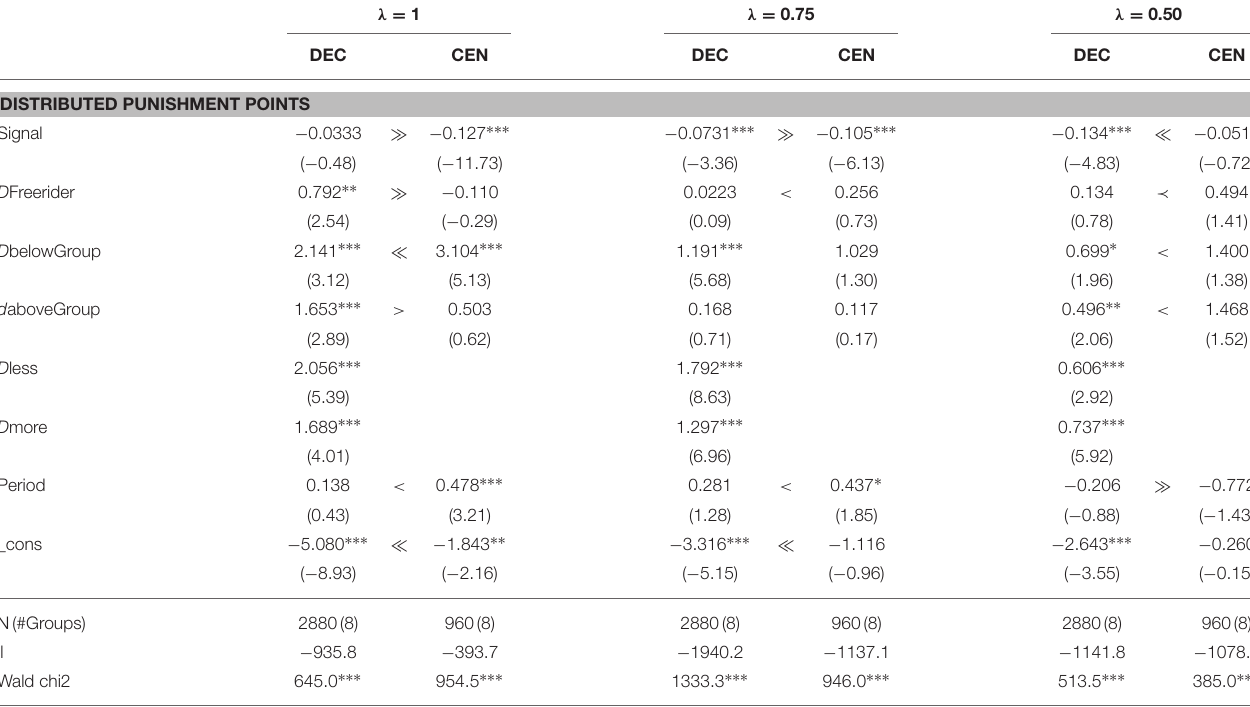
TABLE 3 | Distributed